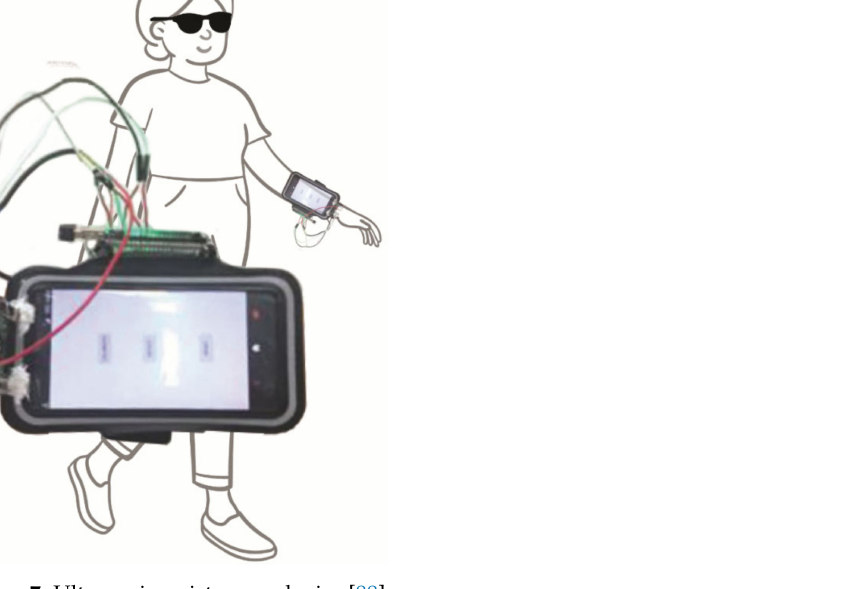
Figure 7. Ultrasonic wrist-worn device